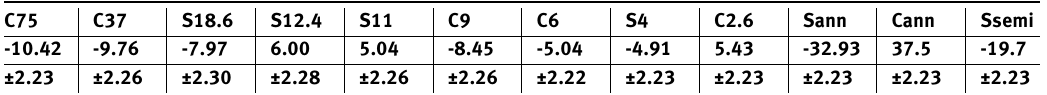
Table 3. The estimated statistically significant components of periodicities and their SEs. C is for cosine, S is for the sine component of a periodicity and the concatenated numbers are the rounded periods in years given in Table 1. Units are in mm.